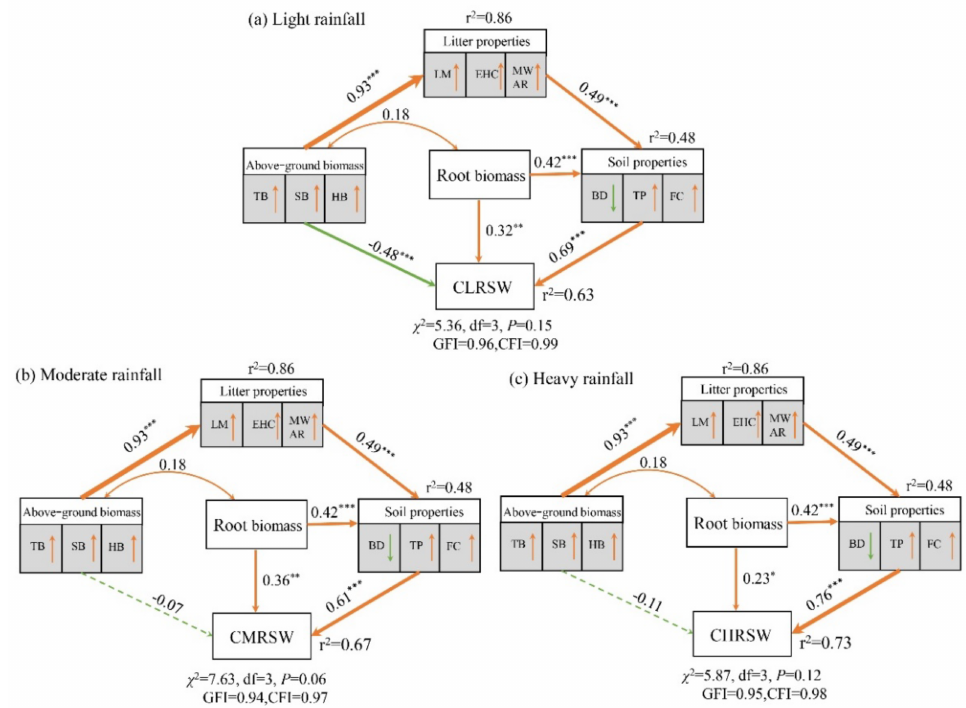
Figure 6. Structural equation models showing the multivariate effects on the contribution of rainfall to soil water. The double-layered rectangle represents the first principal component of the principal component analysis (PCA) for above-ground biomass, litter and soil properties. Above-ground biomass includes TB (tree biomass), SB (shrub biomass) and HB (herb biomass). Litter properties include LM (litter mass), EHC (Effective holding capacity) and MWAR (maximum water absorption rate). Soil properties include BD (bulk density), TP (total porosity) and FC (field capacity). CLRSW: the contribution of light rainfall to soil water; CMRSW: the contribution of moderate rainfall to soil water and CHRSW: the contribution of heavy rainfall to soil water. The numbers on the arrows are the standardized path coefficients. The larger path coefficients are reflected by the width of the arrow, with the orange solid lines indicating a significantly positive effect, the green solid lines indicating a significantly negative effect and the blue dashed lines indicating that the effect was not significant. The goodness-of-fit statistics of the model are displayed below the model. * p < 0.05, ** p < 0.01, *** p < 0.001.